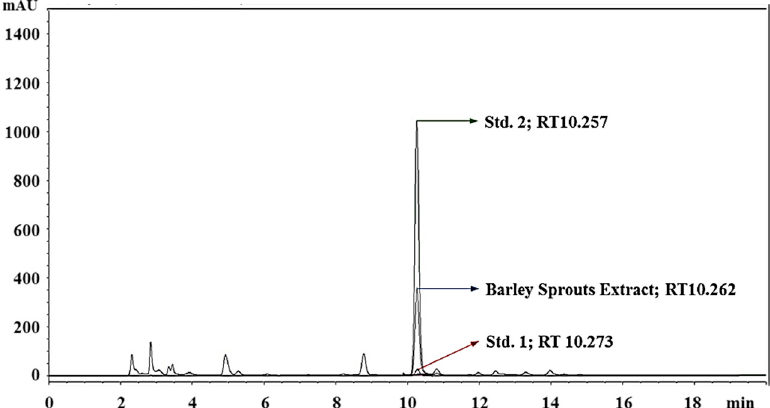
Figure 2. Standardization of barley sprout extract by determination of saponarin by HPLC. Std. 1, saponarin (1 μ M); Std. 2, saponarin (10 μ M); RT, retention time.